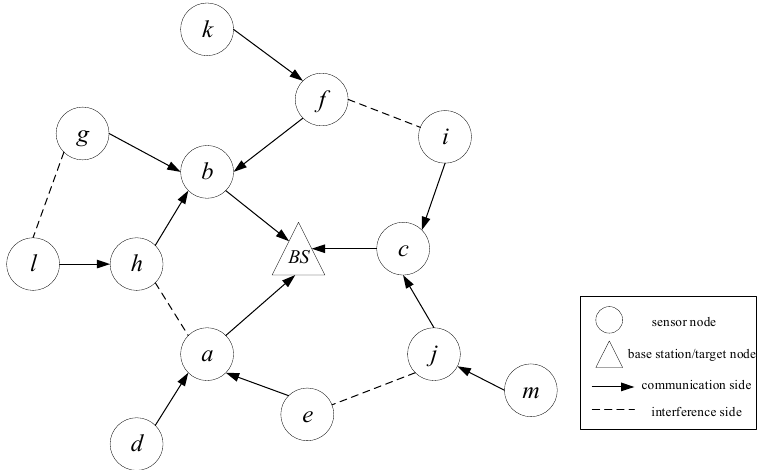
Figure 1. Communication topology of WSNs.